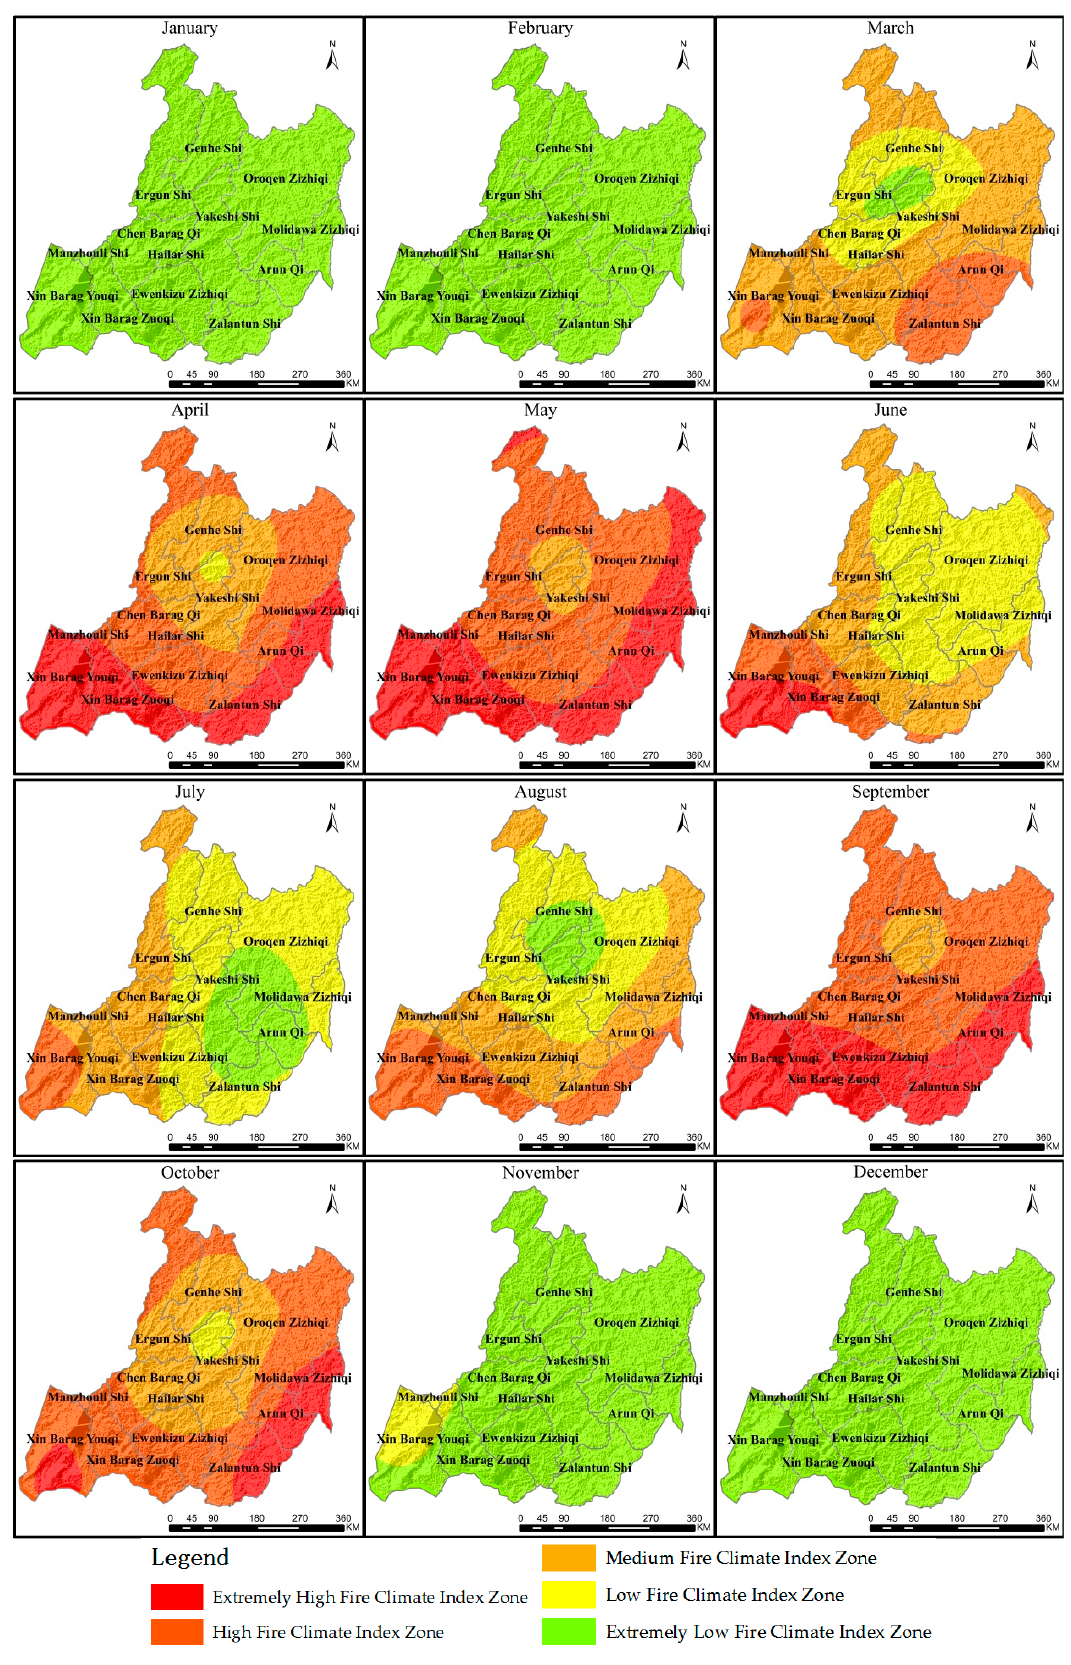
Figure 4. The distribution of monthly grassland fire climate in HulunBuir.